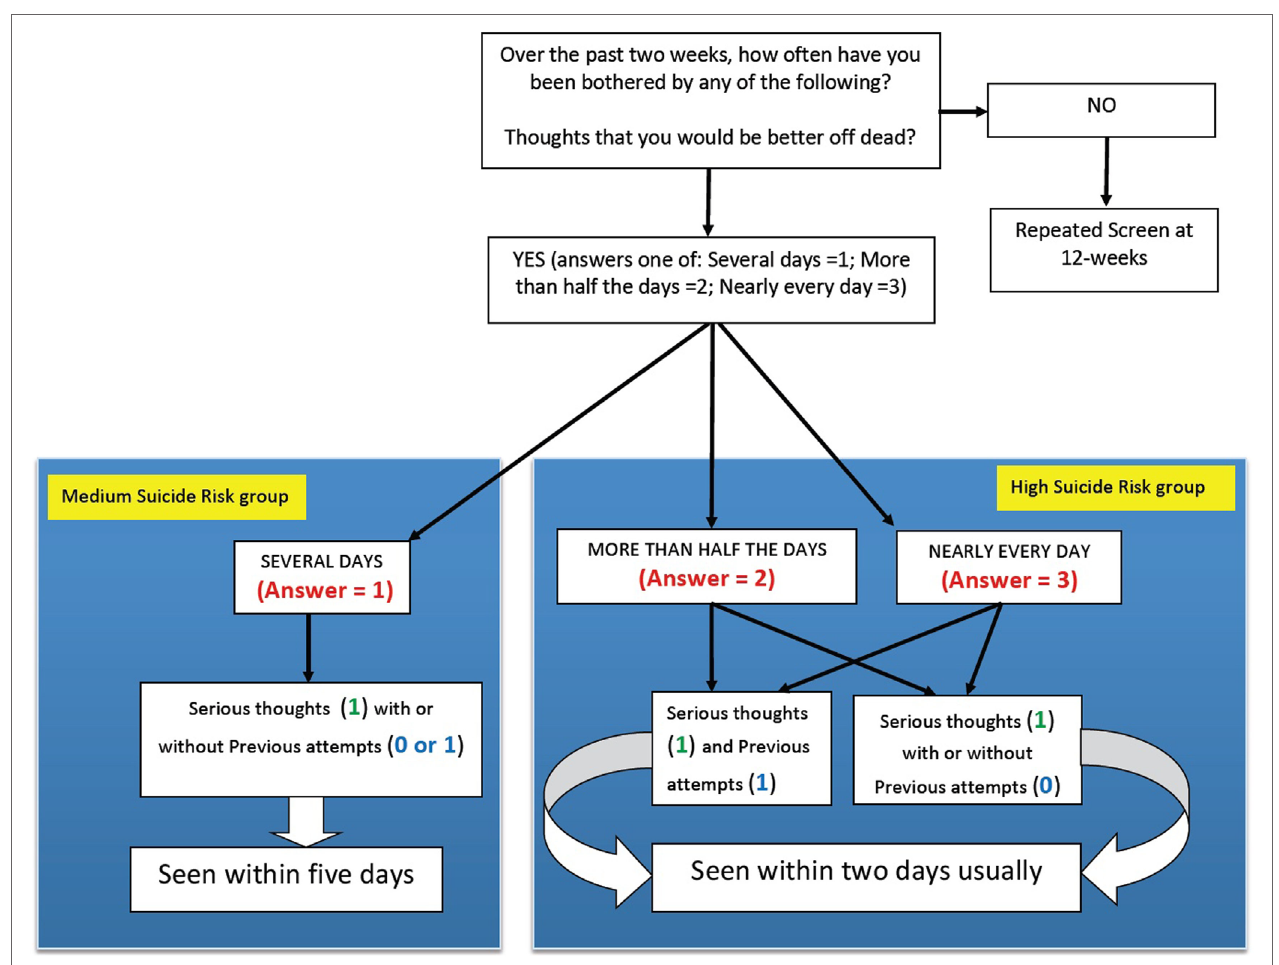
FigUre 1 | algorithm for determining which students were in the “actively suicidal” group . Shows how scores on the questions regarding suicide risk determined if the student was in the high suicide risk group or the medium suicide risk group. Together, these students were considered the “actively suicidal" group, and were interviewed individually within 2 days in most cases, and everybody had been interviewed within 5 days of completing the